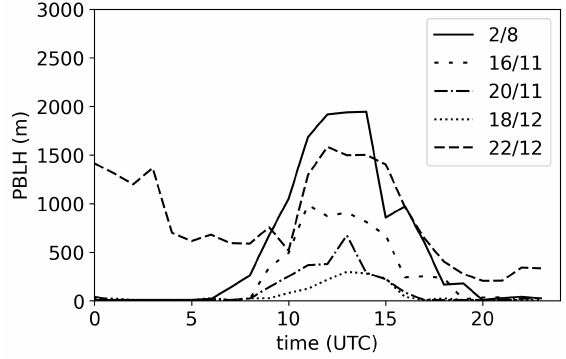
Figure 4. Modeled PBLH profiles in Manlleu for all the studied